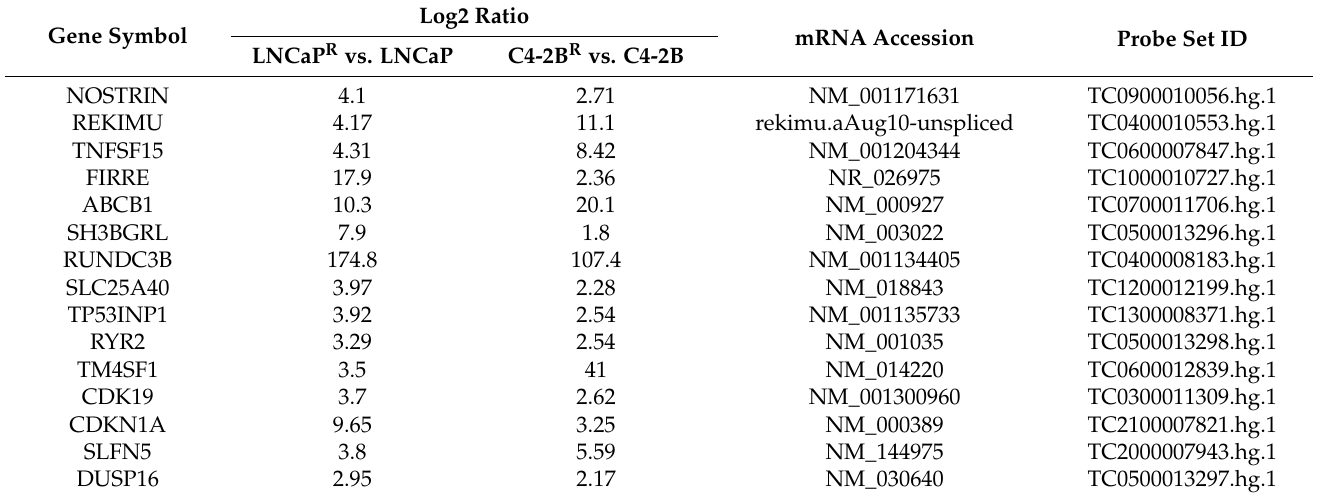
Table 1. Up-regulated genes in both LNCaP R and C4-2B R .